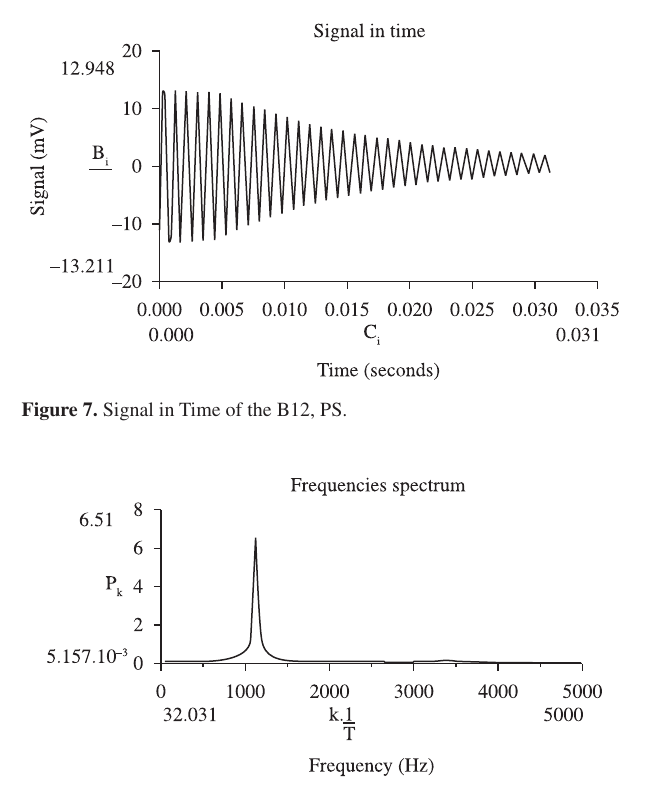
Figure 10. Micrography of granite-epoxy composite, A12 PS